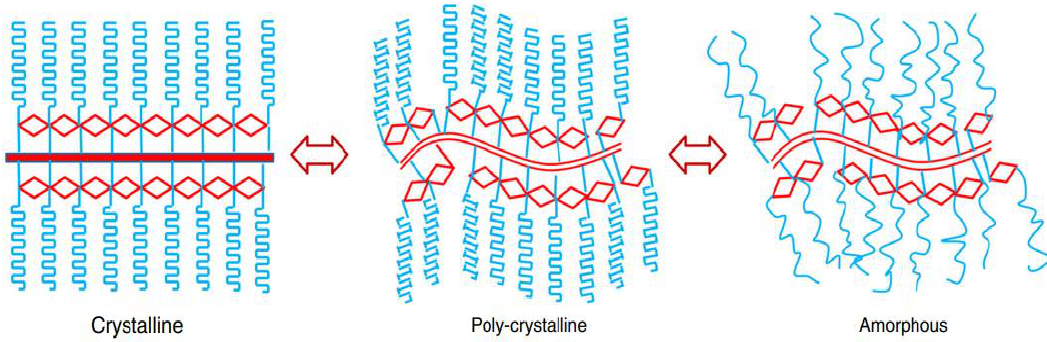
Figure 9. Polymeric SS-PCM phase transition characteristics [107].